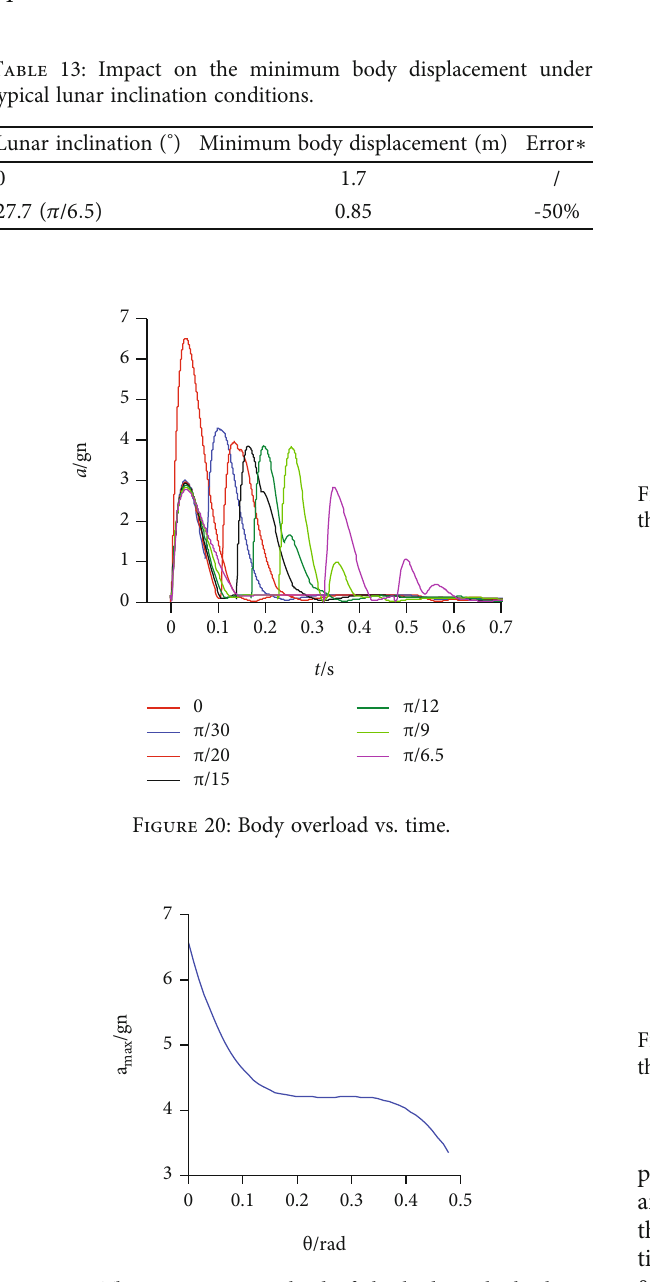
Figure 21: The maximum overload of the body with the lunar inclination. Table 14: Impact on the maximum body overload under typical lunar inclination conditions.